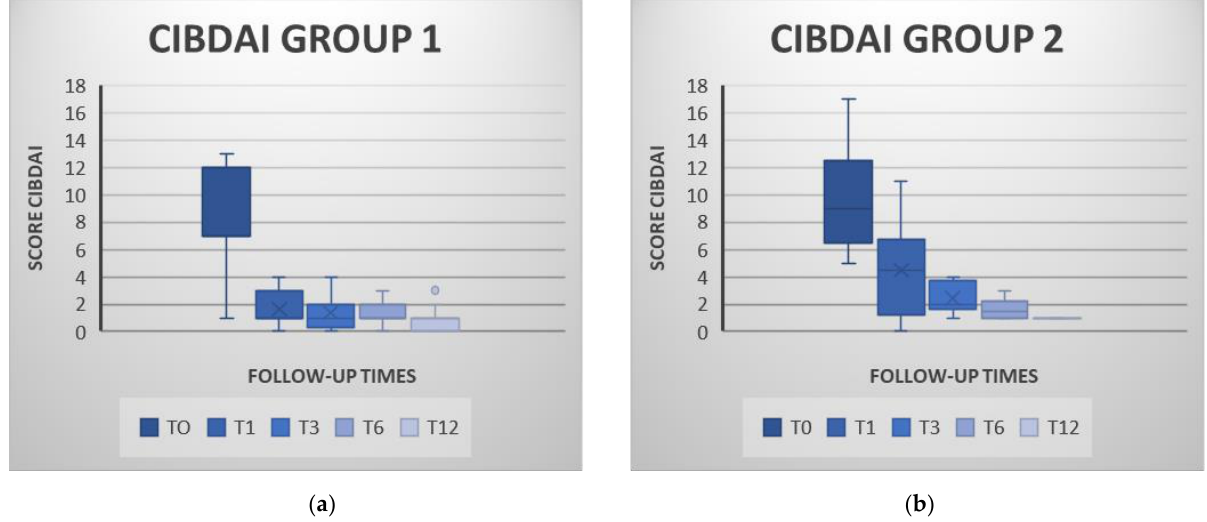
Figure 2. Values of the Clinical Inflammatory Bowel Disease Activity Index (CIBDAI) for the cell therapy group (MSC group; figure ( a )) and for the combined prednisone and stem cells group (P-MSC group; figure ( b )) at each check point. In both groups, it can be observed how the CIBDAI decreases progressively over the successive control points, highlighting the decrease between T0 and T1. Box and Whisker Plot: The graphs show the median (line inside the box), 25th and 75th percentiles (box) and minimum and maximum values